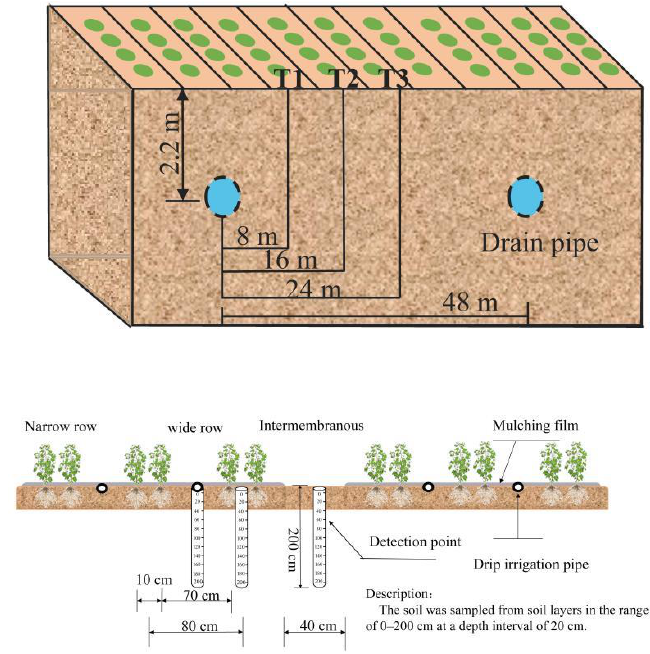
Figure 2. Schematic showing the cotton planting pattern. Table 1. Irrigation details of the study area in the year 2013 – 2014.